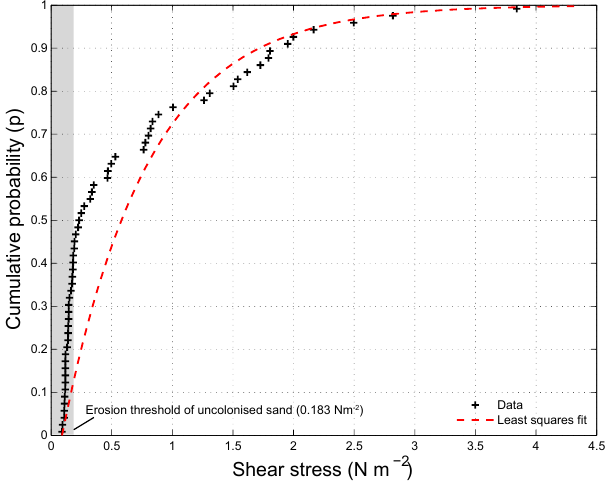
Figure 2. Shear stress measurements made with CSM erosion de- vice during natural biofilm growth experiment. The measurements ( n = 61) are best described by a least squares exponential fit with a mean parameter µ of